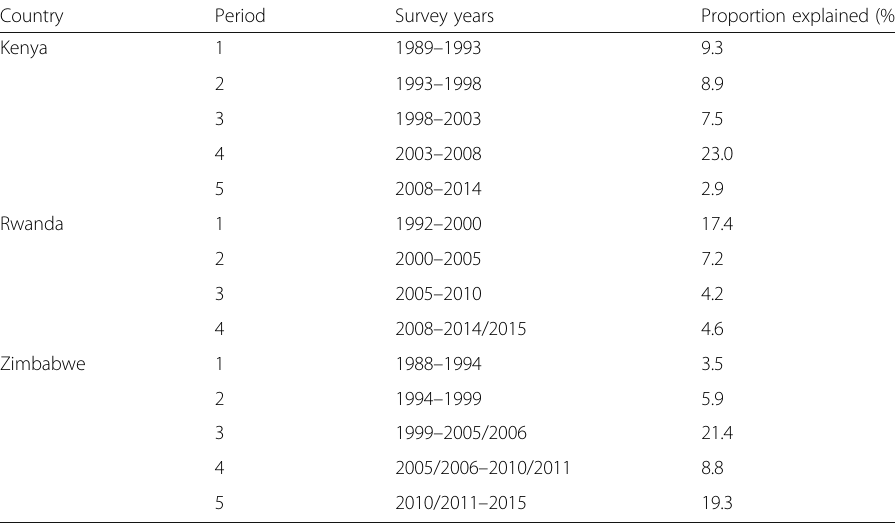
Table 4 Proportions of the changes in ASMFR explained by the model Country Period Survey years Proportion explained (%)